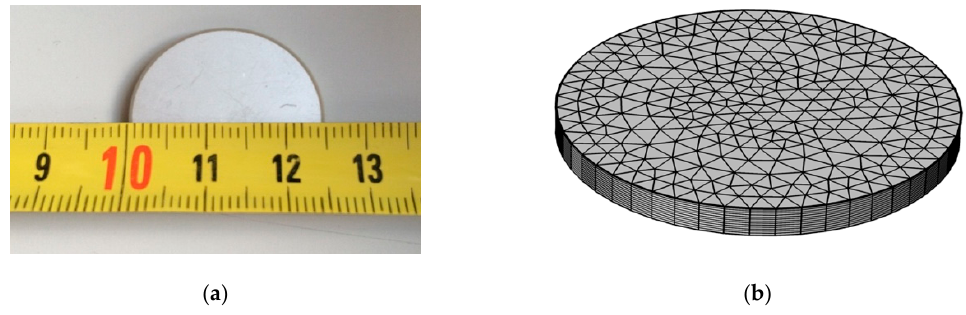
Figure 2 . ( a ) PIC 255 Ceramic disc measured; ( b ) Mesh geometry for the finite element method.